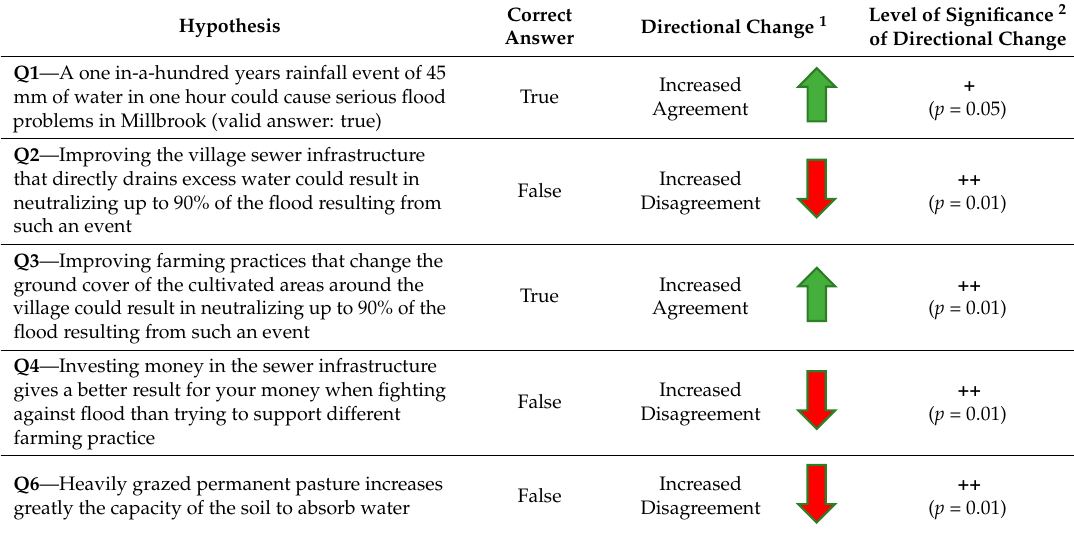
Table 2. Playing the game induces a directional change in the way participants confirm or reject the seven hypotheses.